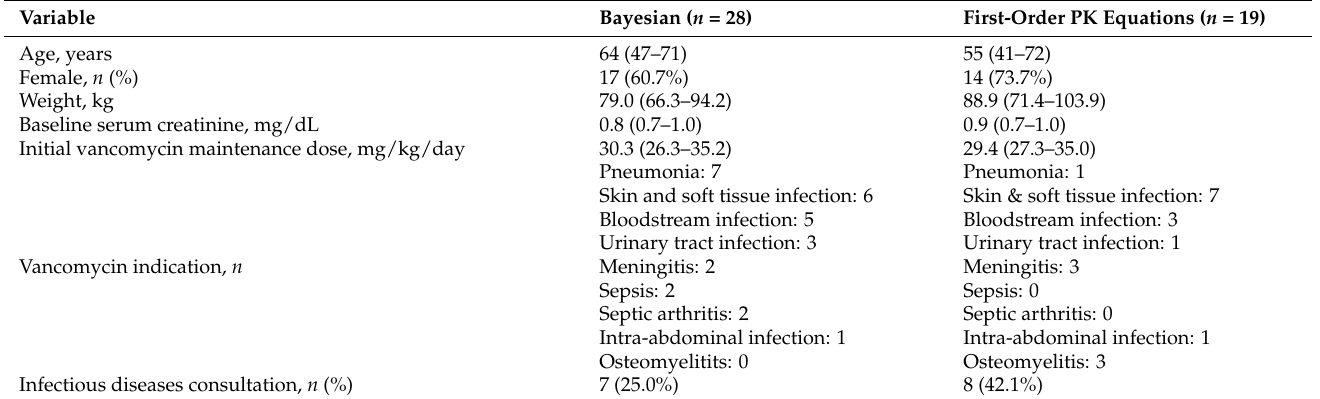
Table 1. Baseline